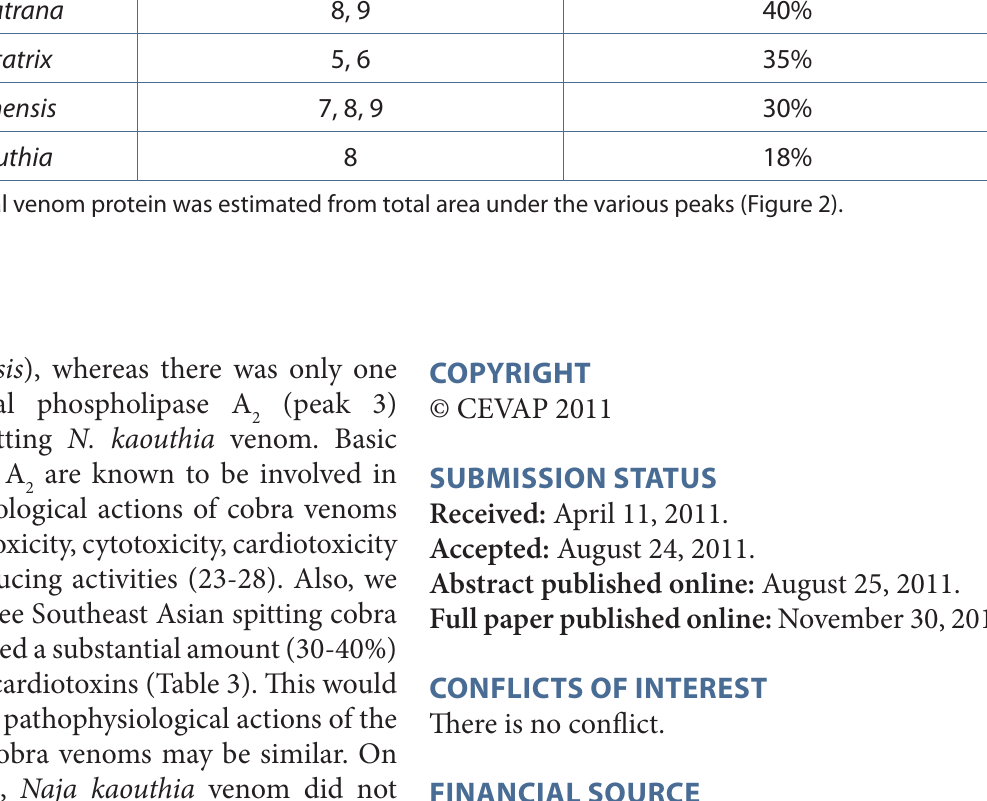
Table 3. Cardiotoxin contents in the four Southeast Asian cobra venoms.